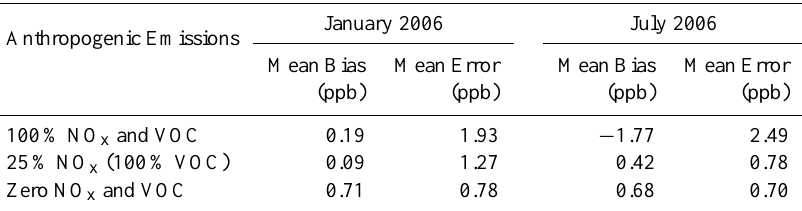
Table 2. Statistical evaluation over 22 cities of using Eq. (3) to predict ozone with 100% NO x and VOC, 25% NO x (100% VOC), and zero NO x and VOC anthropogenic